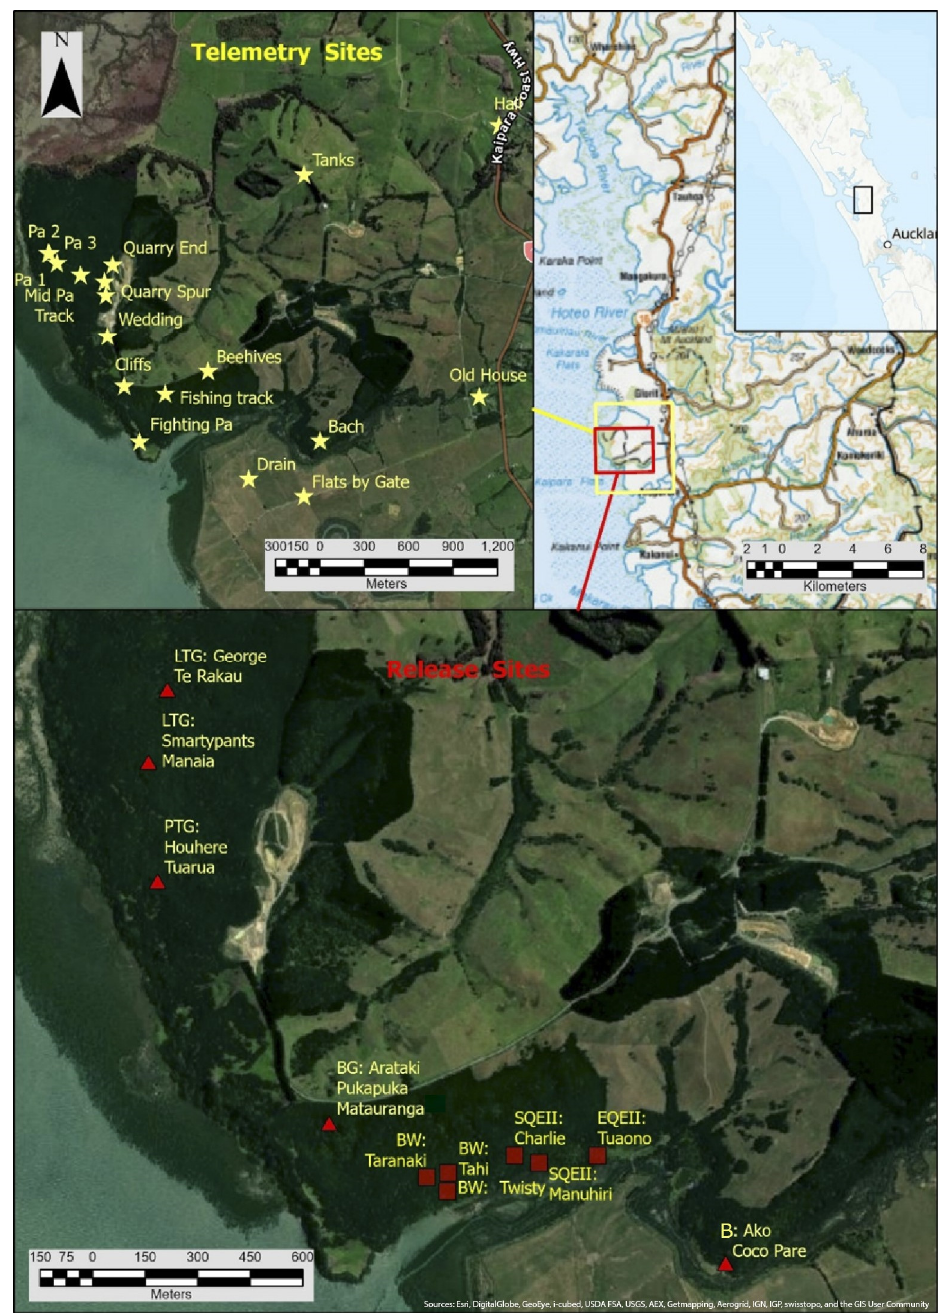
Figure 1. Location of Mataia Restoration Project in relation to the Kaipara Harbour, North Island, New Zealand (inset map), sites where birds were released in 2013 (red squares) and 2014 (red triangles) (B Bach, BG Big Gully, BW Boardwalk, EQEII Eastern QEII Block, LTG Lemon Tree Gully, PTG Peach Tree Gully, SQEII Southern QEII block with individual birds at each site (lower bottom) and 16 telemetry sites used in 2014 (upper left, stars)(‘Hall’ site was not used).